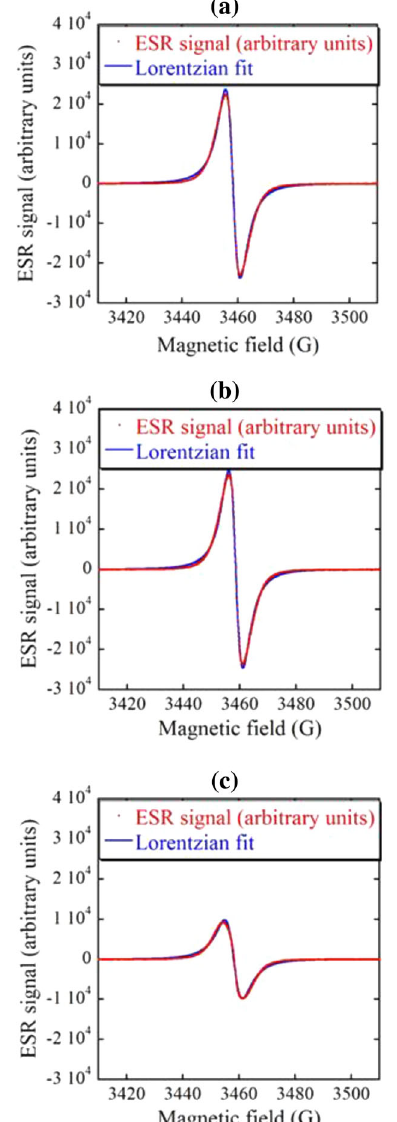
Fig. 2 ESR spectra for a the parent, b inertinite-rich, and c vitrinite- rich coal